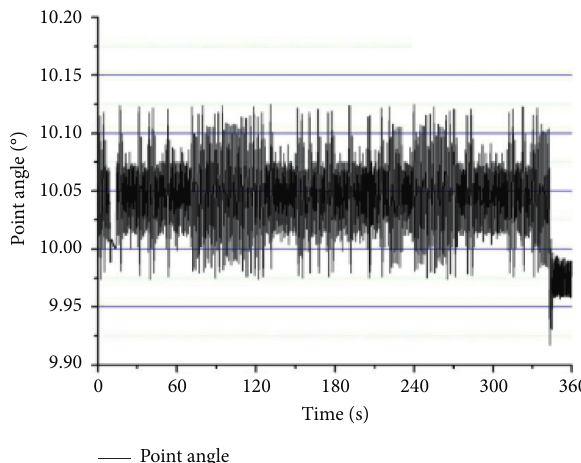
Figure 24: Tracking effect at 0.1 ° /s triangle wave